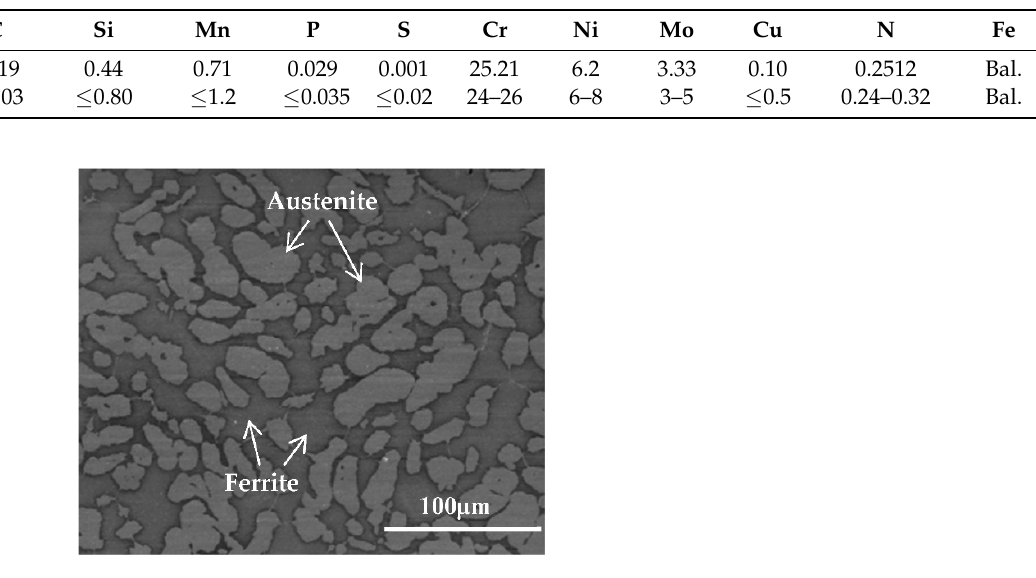
Table 1. Chemical composition of S32750 SDSS (wt%).